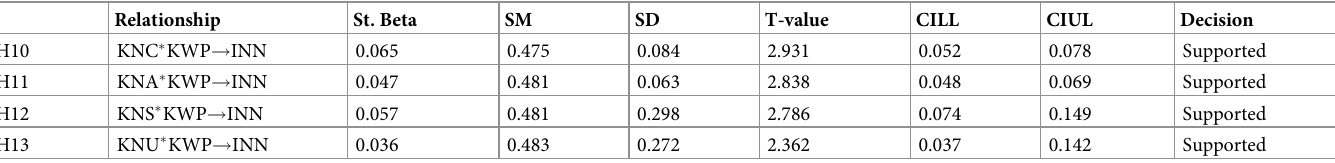
Table 6. Results of indirect effects (hypothesis testing).